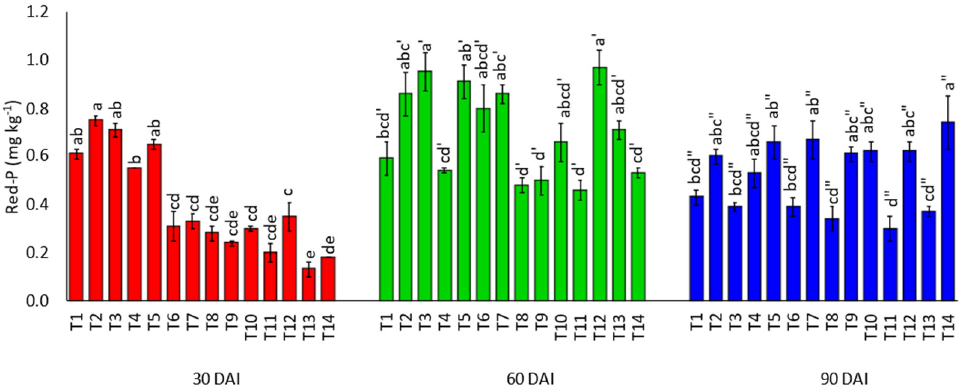
Figure 19. Effects of treatments on reductant soluble phosphorus after thirty, sixty, and ninety days of incubation, where T1: soil alone, T2: Egypt rock phosphate alone, T3: Egypt rock phosphate + 100% charcoal, T4: Egypt rock phosphate + 100% sago bark ash, and T5: Egypt rock phosphate + 100% charcoal + 100% sago bark ash, T6: Egypt rock phosphate + 75% charcoal + 75% sago bark ash, T7: Egypt rock phosphate + 50% charcoal + 75% sago bark ash, T8: Egypt rock phosphate + 25% charcoal + 75% sago bark ash, T9: Egypt rock phosphate + 75% charcoal + 50% sago bark ash, T10: Egypt rock phosphate + 50% charcoal + 50% sago bark ash, T11: Egypt rock phosphate + 25% charcoal + 50% sago bark ash, T12: Egypt rock phosphate + 75% charcoal + 25% sago bark ash, T13: Egypt rock phosphate + 50% charcoal + 25% sago bark ash, and T14: Egypt rock phosphate + 25% charcoal + 25% sago bark ash. Means with different letter(s) within the same incubation period indicate significant differences between treatments according to Tukey’s HSD test at p ≤ 0.05, i.e., a > b > c. Bars represent the mean values ± SE.